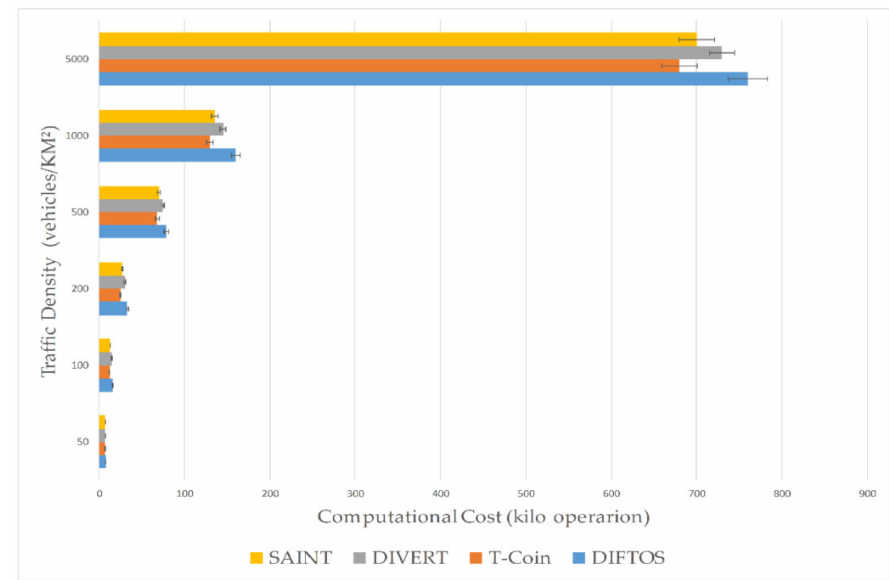
Figure 11. Tra ffi c density vs. tra ffi c server computational